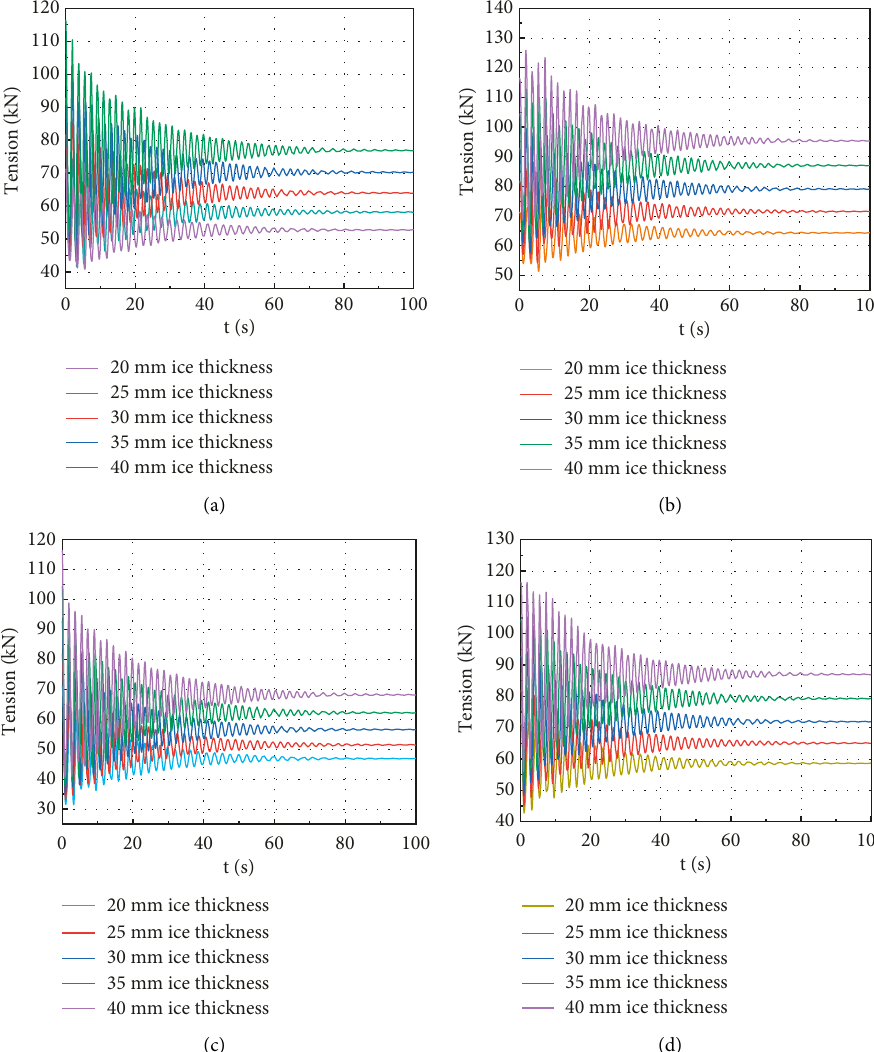
Figure 8: Tension-time curves of subconductor with different icing thickness: (a) A1 conductor, (b) A2 conductor, (c) A3 conductor, (d) A4